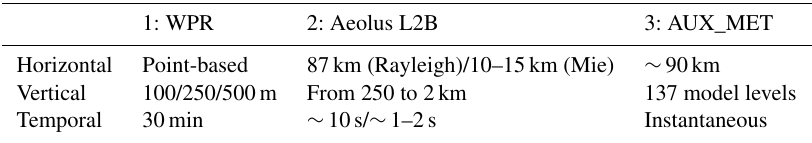
Table 2. Spatial and temporal resolution of the three data sets.